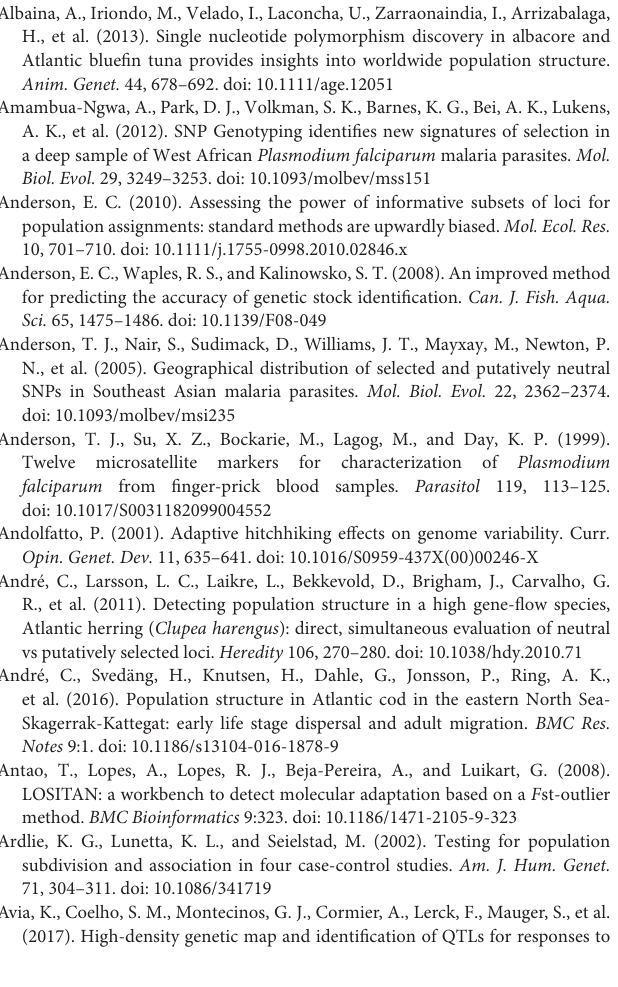
individuals from site CW (north) and blue dots denote individuals from site KW (south). Most points were close to the center diagonal line and quantitatively, D LR values were < 3 in all comparisons with SNPs and microsatellites, indicating low assignment power of migrants. Supplementary Table 1 | Characteristics of different SNP multiplexing platforms and their applications based on previous studies across biological organisms (literature from 2011-present) as compared to microsatellites. Asterisk indicates the platform used in the present. Supplementary Table 2 | Comparison of nucleotide diversity among the different types of SNPs. Groups with the same index letters were not significantly different at p = 0.05. Supplementary Table 3 | Correlation of F ST matrices among SNP and microsatellite datasets by Mantel test. Correlation coefficient (r, lower diagonal) and p -value (upper diagonal) were indicated. At alpha = 0.05, we reject the null hypothesis that the two matrices were unrelated, i.e., a significant correlation was observed when p -value ≤ 0.05 (number in bolded). HP, High